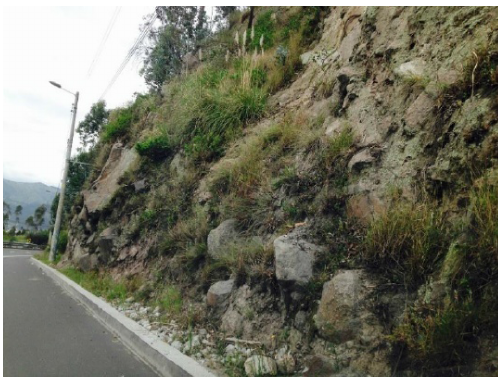
Figure 5. Rocky soil in Quito, V s30 = 466.27ms − 1 . Metropolitan